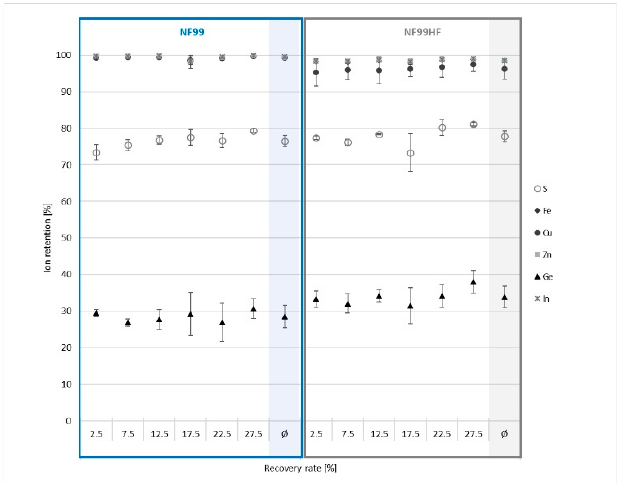
− 1 , 25 ◦ DI (15 bar, 1.25 m s